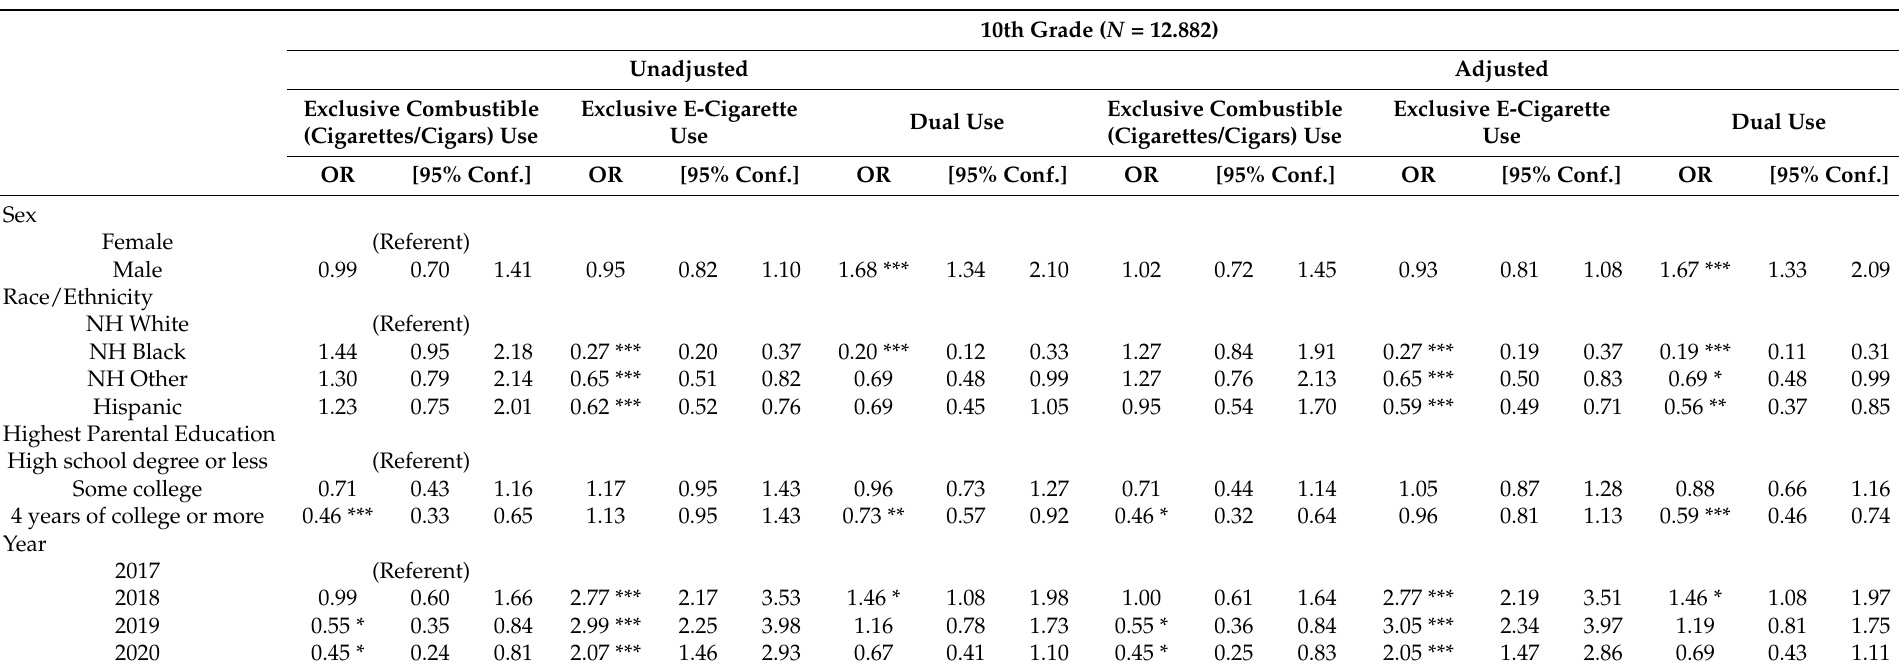
Table 3. Multinomial Regression Models of Sociodemographic Factors associated with Exclusive and Dual use of E-cigarettes with Combustibles (cigarettes and cigars) among tenth graders: Monitoring the Future Surveys, 2017 to